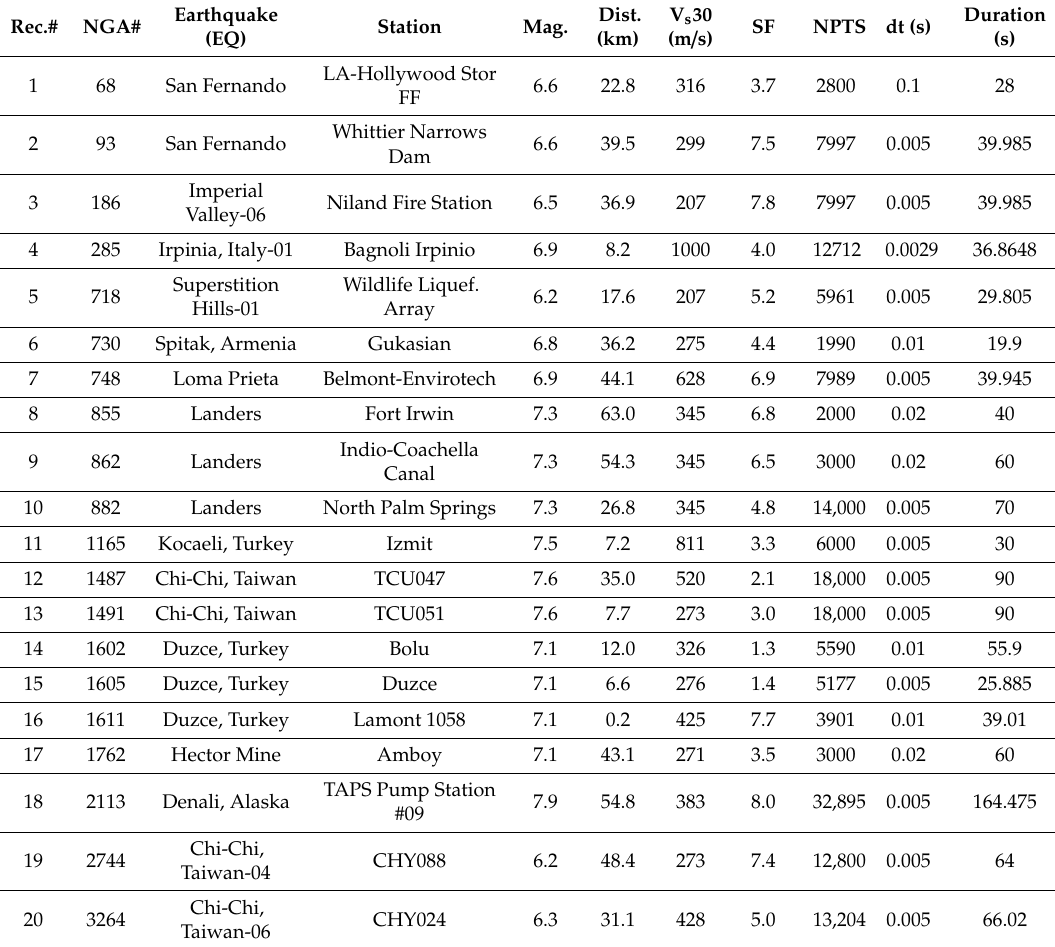
Table 3. Properties of the 20 motions